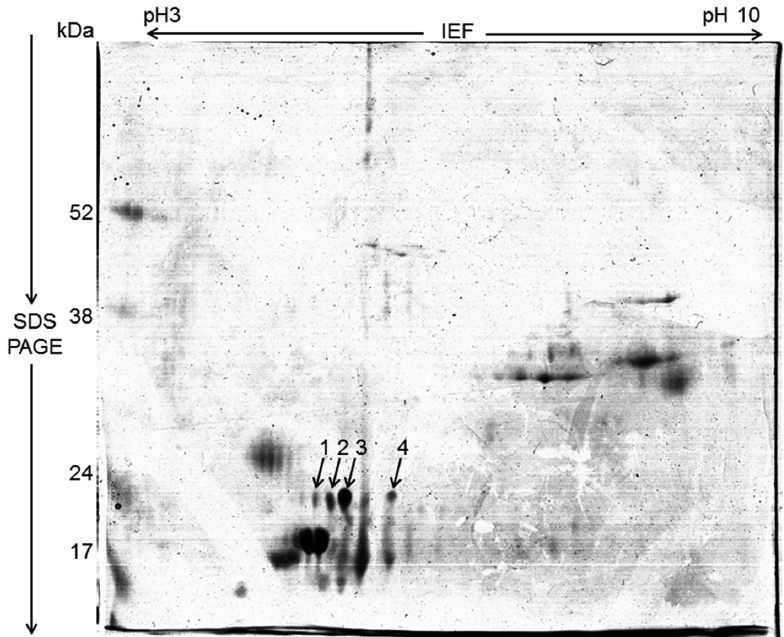
Figure 1 - Proteome pro fi le of Tityus stigmurus venom (TsV) on